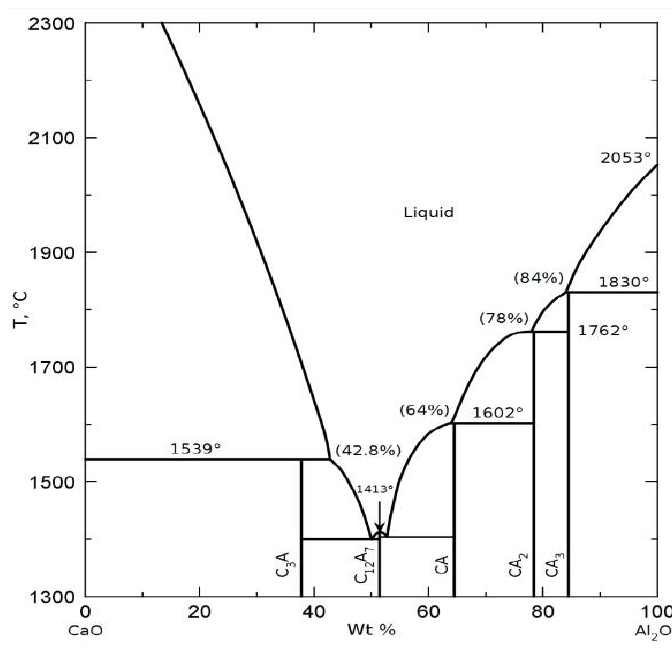
Figure 1. CaO-Al 2 O 3 two component system, according to [15].